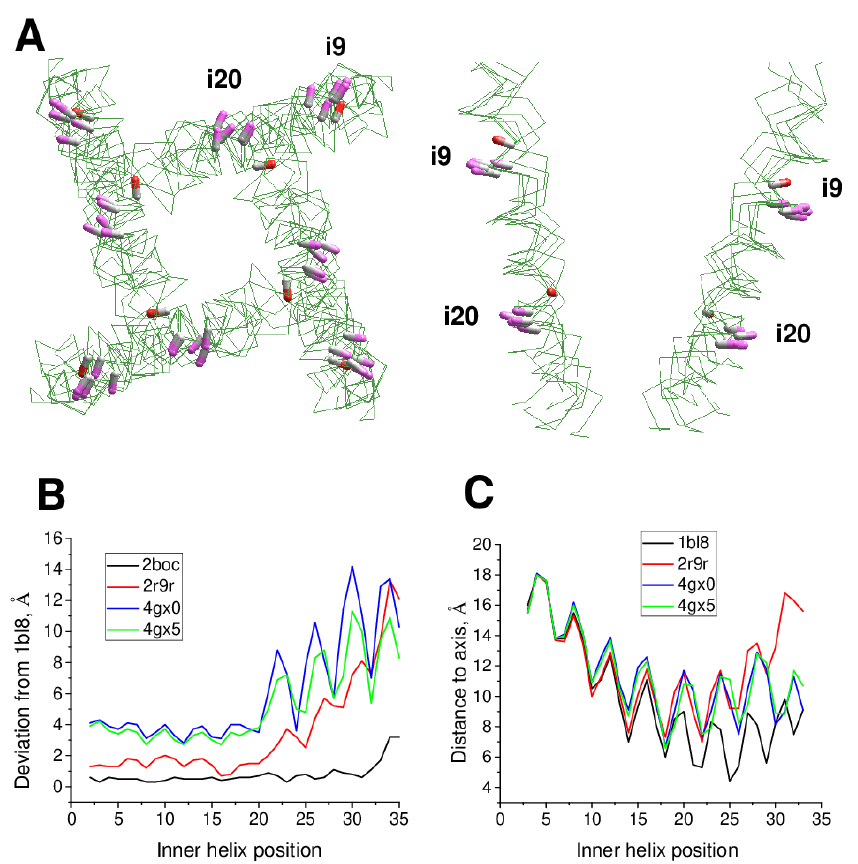
Figure 4. π -Bugles in the inner helices of P-loop channels. ( A ), Intracellular and membrane vies at superimposition of KcsA (PDB ID: 1bl8), Kv1.2/Kv2.1 (PDB ID: 2r9r), AMPAR (PDB ID: 6dm0), NavAb (PDB ID: 3rvy), NavMs (PDB ID: 6yz0), and GsuK (PDB ID: 4gx5). CA-CB bonds in positions i9 and i20 are shown as sticks. Upstream from the π -bulge (position i9), orientations of CA-CB bonds (gray CA, pink CB) are similar, while downstream the bulge (i20 position), orientation of CA-CB bonds in GsuK (gray CA, red CB) is different from that in other channels. ( B ), Deviations of alpha carbons in representative structures of P-loop channels from sequentially matching positions in the KcsA structure (PDB ID: 1bl8). Another KcsA structure (PDB ID: 2boc) has small deviations. For the open-gate Kv1.2/Kv2.1 channel, the deviations are large at the C-terminal part, but the deviation plot remains rather smooth. For the GsuK structures (PDB IDs: 4gx0, 4gx5), with a bulge in the middle of the inner helix, large oscillations are seen at the plots. ( C ), Distances of alpha-carbons in the inner helices from the pore axis. The bulge in the GsuK structures causes a shift of maxima and minima in the distance